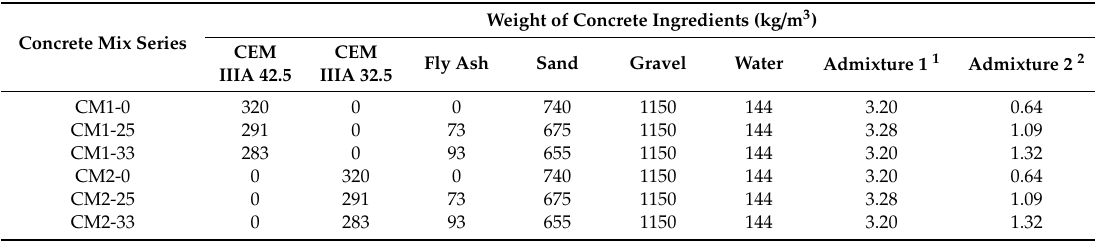
Table 3. Concrete mix